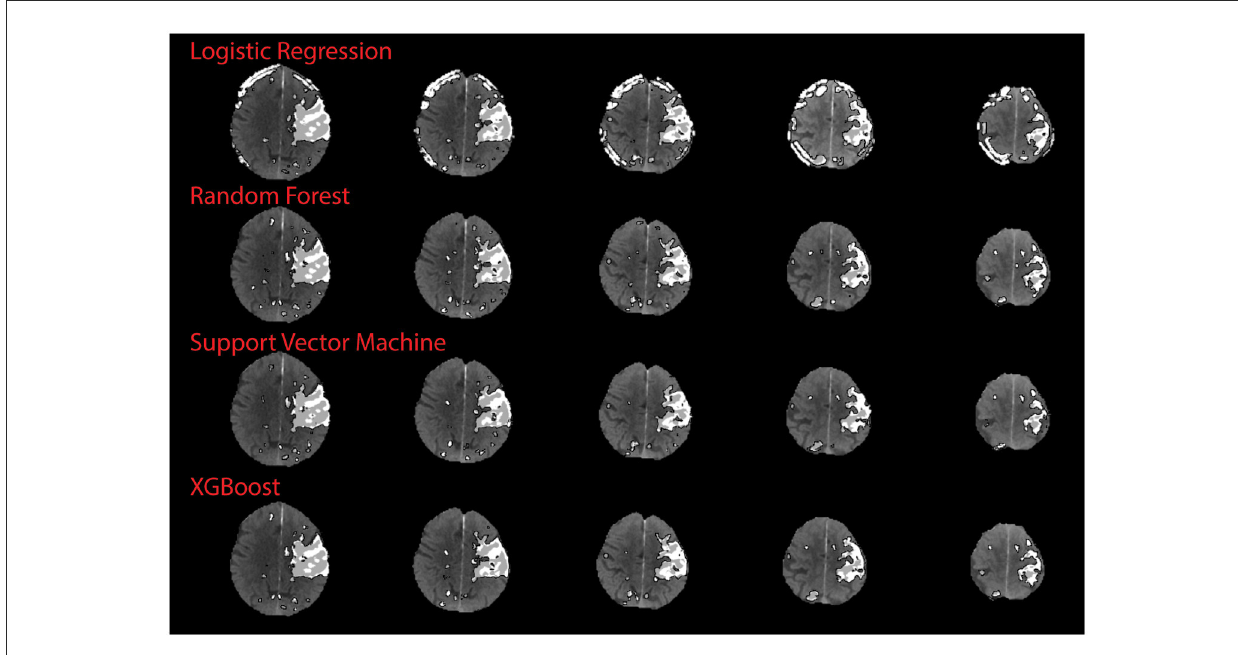
FIGURE5 Qualitative results on skull artifact. Predictions made on subject 3 (shown in Figure 3) for each algorithm. Linear regression performed the poorest in terms of identifying artifact as areas of perfusion, as demonstration by subject 3 axial